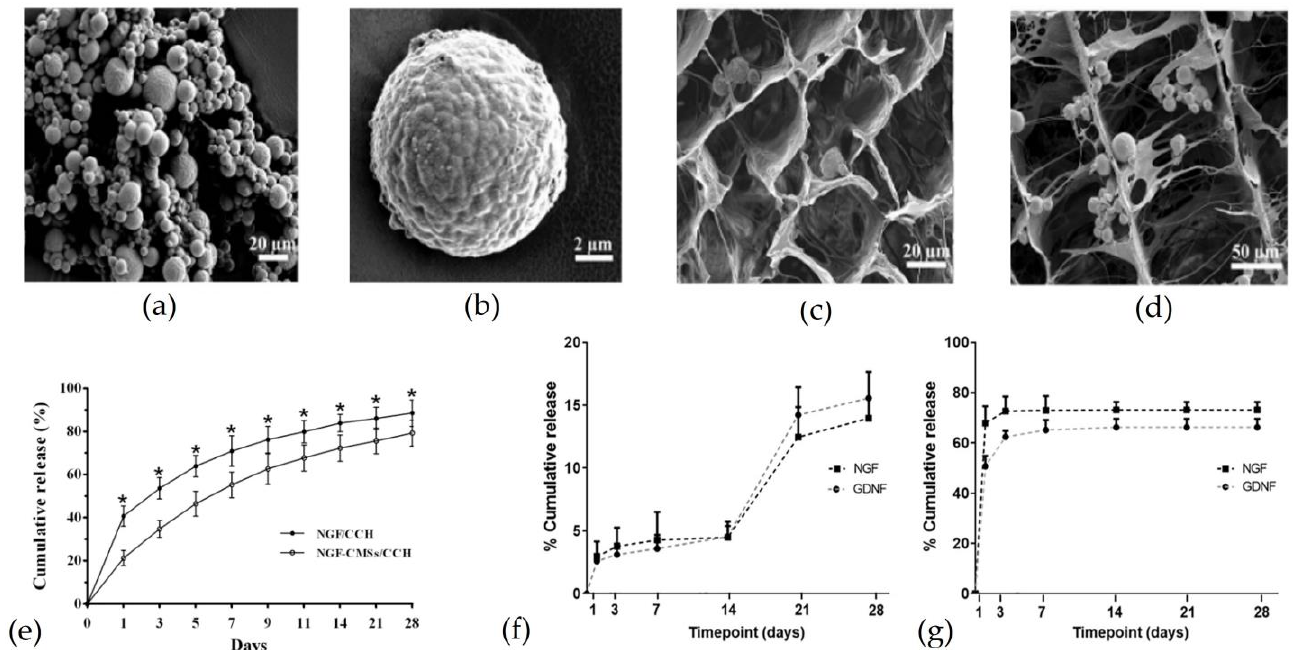
Figure 5. Microparticles as drug delivery systems loaded in nerve guidance channels: ( a , b ) Scanning electron microscopy images of chitosan MPs loaded with NGF. ( c ) SEM images of a transverse section of NGC loaded with NGF-loaded chitosan MPs. ( d ) SEM images of a longitudinal section of NGC loaded with NGF-loaded chitosan MPs. ( e ) Comparison of NGF release from MPs embedded in the NGC (empty dot) and release of NGF loaded directly in the NGC (* = p < 0.05). Reproduced and adapted with permission from [32]. Copyright © Public Library of Science ( f ) NGF and GDNF release from PLGA microparticles loaded in a conduit, ( g ) NGF and GDNF release from a conduit without PLGA microparticles. Reproduced and adapted with permission from [68], Copyright © 2019 Elsevier B.V. Table 2. Schematic list of microparticle studies to enhance nerve regeneration.